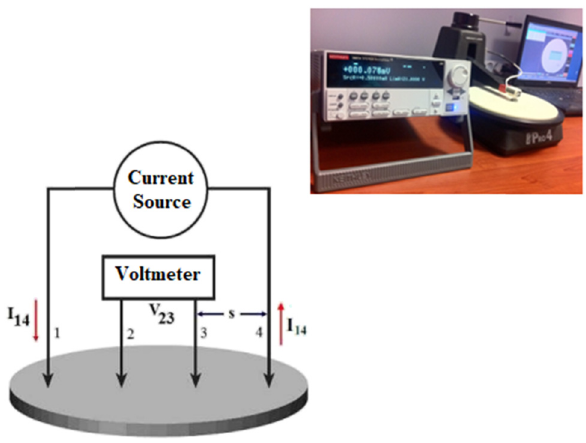
Figure 3: Keithley 2601A System Sourcemeter four - point probe setup and schematic